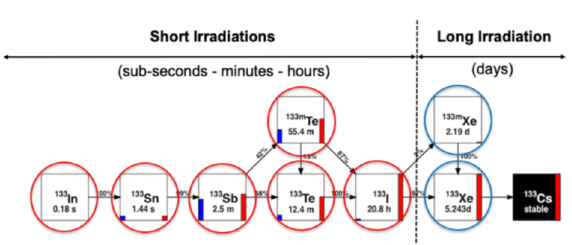
Figure 1. The A = 133 isobar, illustrating the possible fission products. The cumulative FPY of the entire A = 133 isobaric chain is measured using the yield of 133 Xe. Additional measurements of the shorter-lived fission products will be able to provide information on the independent